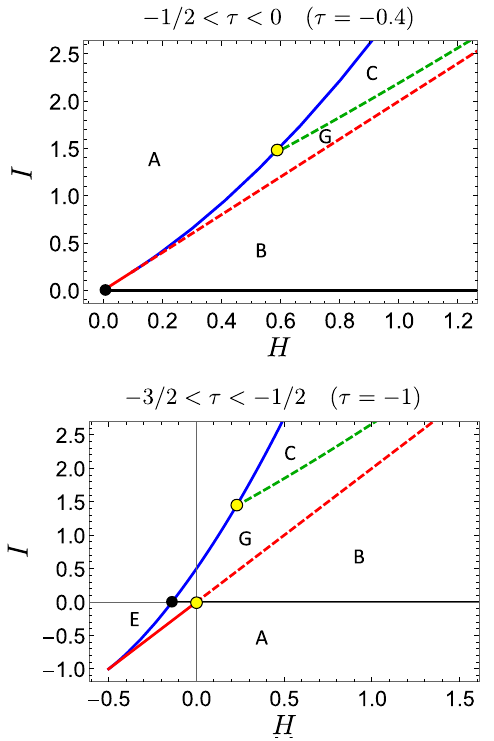
FIG. 17. (Upper) Bifurcation diagram Σ for the insert strength value τ ¼ − 0 . 4 , dividing the ð H; I Þ plane into four distinct regions. (Lower) Bifurcation diagram Σ for the insert strength parameter τ ¼ − 1 , dividing the ð H; I Þ plane into five distinct regions. The cusp at ð − 1 = 2 ; − 1 Þ corresponds to the pair of singular points, excluded from the phase space M